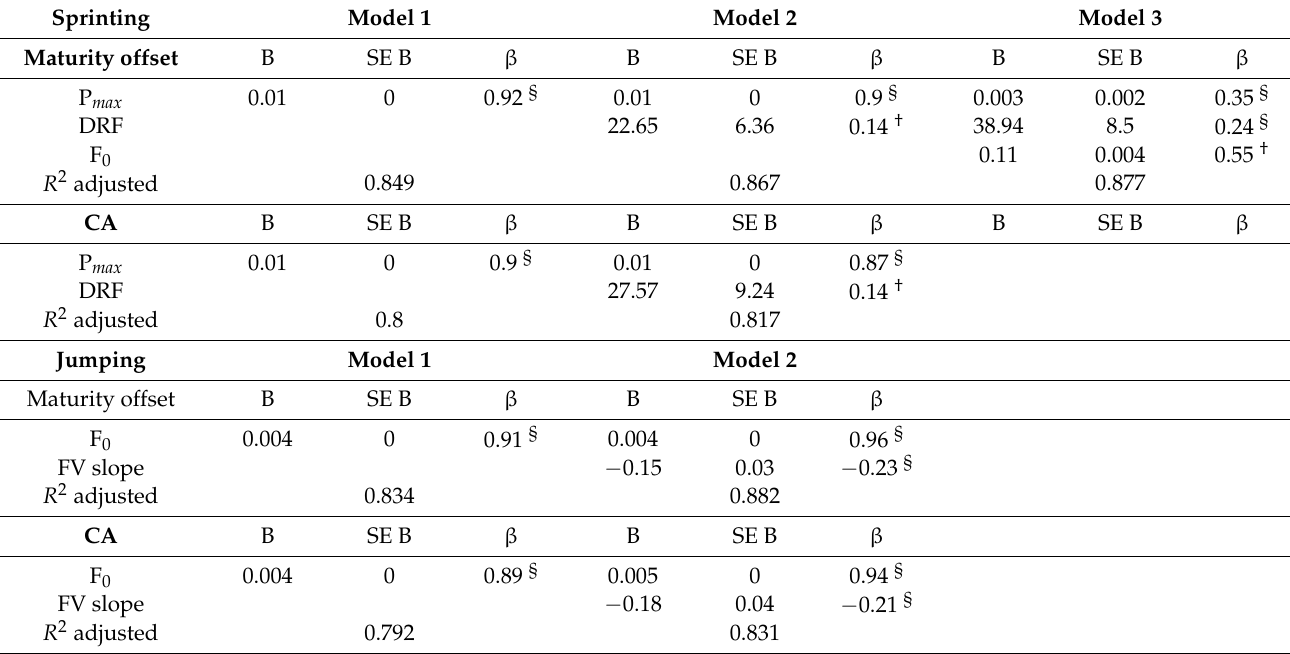
Table 3. Stepwise regression analyses relating both maturity offset and chronological age (CA) with components of force-velocity (FV) profiles in sprinting and jumping.